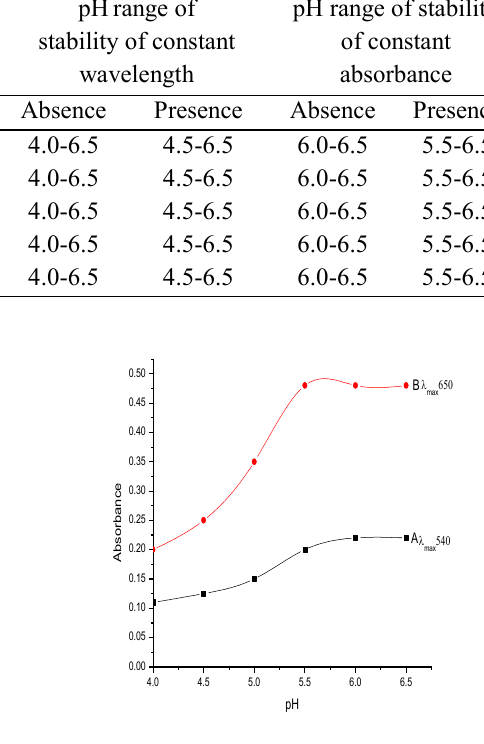
with change in the max